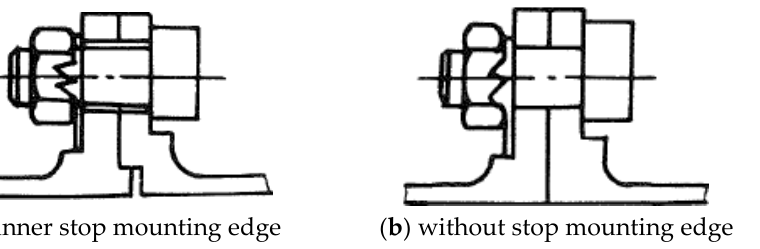
Figure 2. Flange mounting edge bolted connection structure of aero-engines.